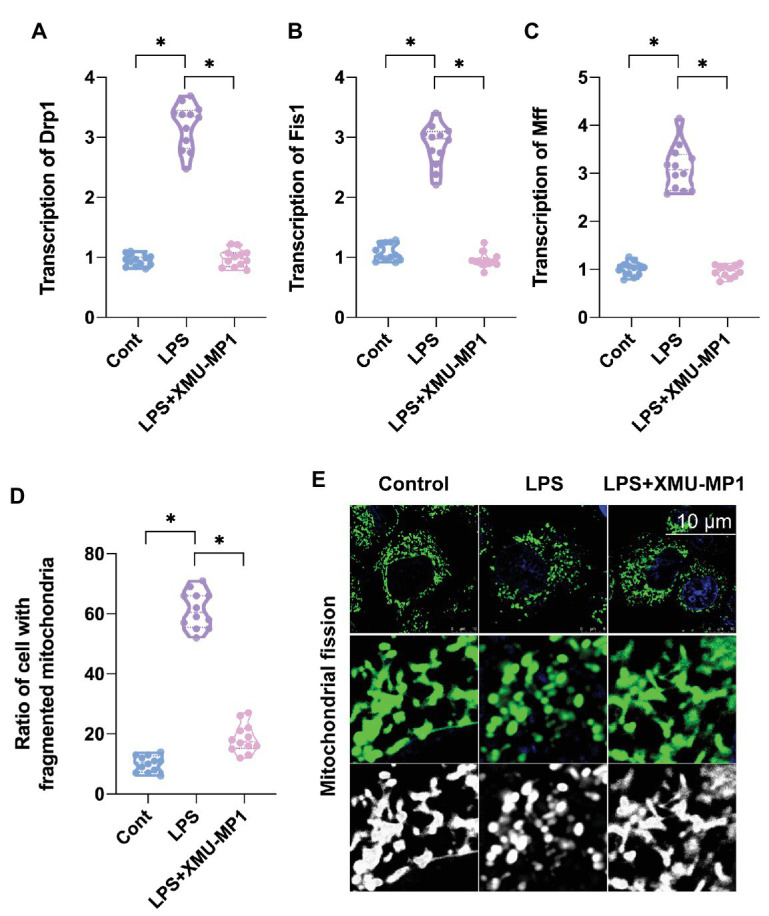
Mst2 induces excessive mitochondrial fission in LPS-treated H9C2 cardiomyocytes. (A–C) QRT-PCR analysis shows Drp1, Mff, and Fis1 levels in the control, LPS-treated, and XMU-MP1 plus LPS-treated H9C2 cells. (D,E) Representative immunofluorescence images show Alexafluor-594-tagged-anti-TOM20 antibody-stained control, LPS-treated, and XMU-MP1 plus LPS-treated H9C2 cells. Also shown is the quantification of the ratio of fragmented mitochondria in control, LPS-treated, and XMU-MP1 plus LPS-treated H9C2 cell groups. LPS treatment was performed for 24 h. H9C2 cells were pre-treated with the Mst2 blocker, XMU-MP1 for 6 h before treatment with LPS treatment. *
p < 0.05.